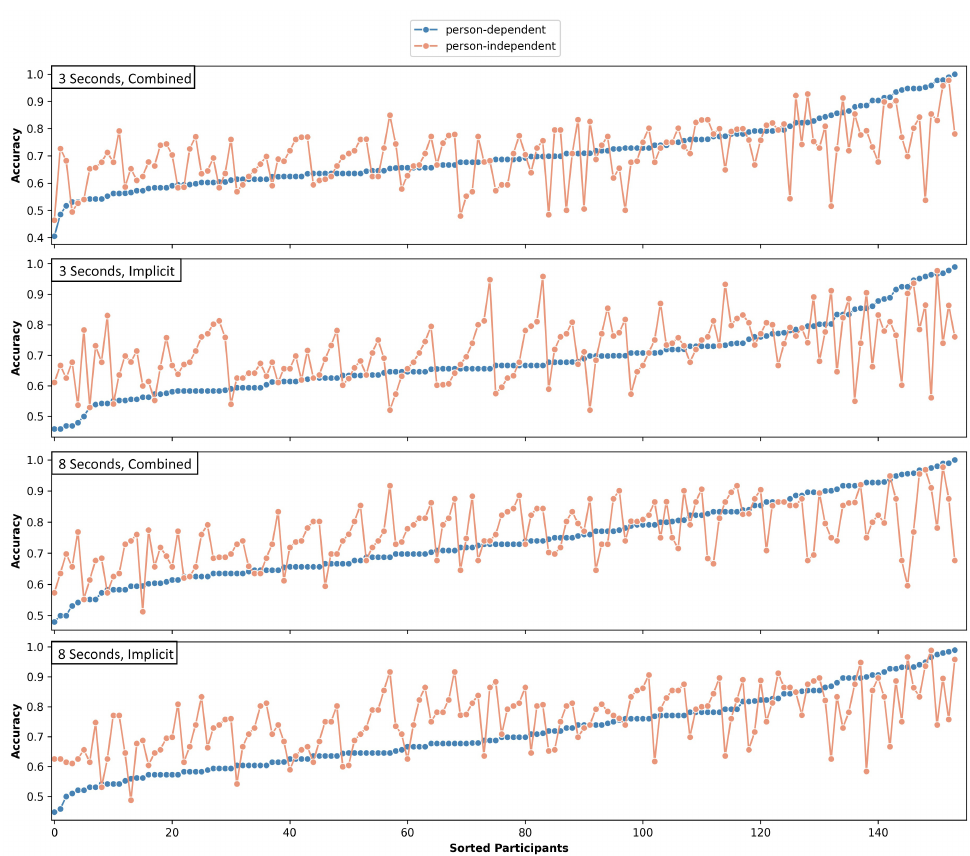
Figure 4. Person-dependent and person-independent classification accuracies per participant. Each plot is sorted individually by ascending person-dependent classification